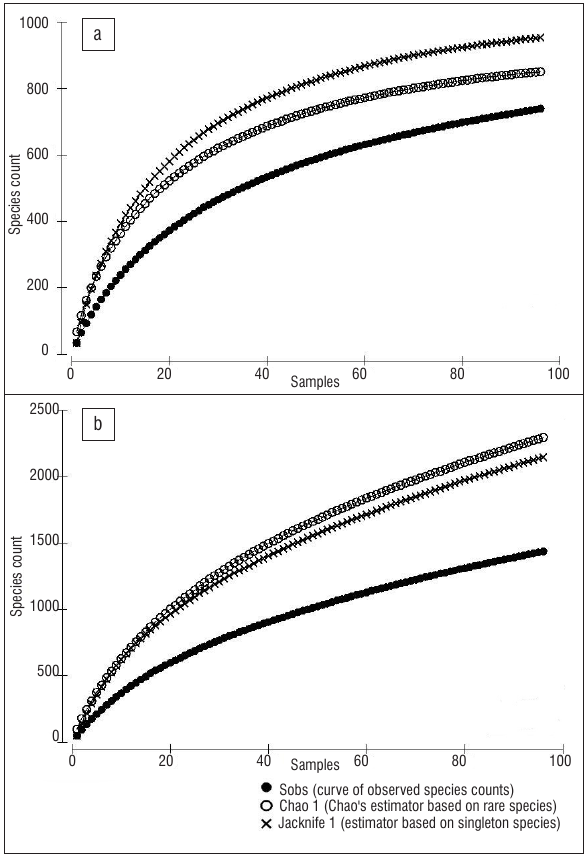
Figure 2: Species accumulation curves for (a) plants and (b) arthropods sampled in all grassland and savanna